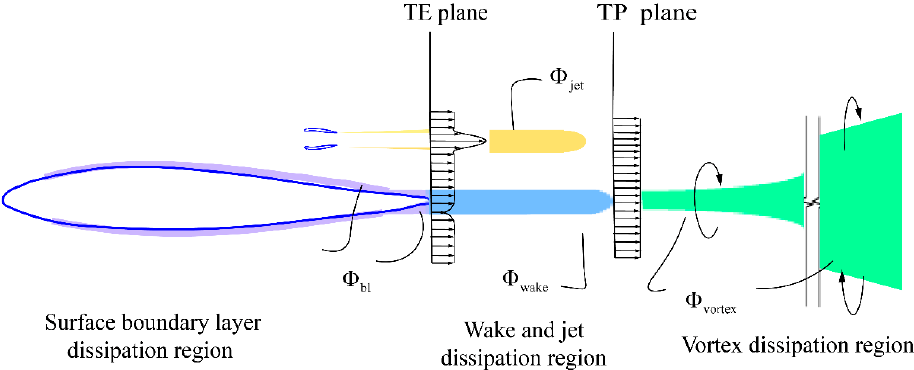
Figure 3. Viscous dissipation in different viscous regions.